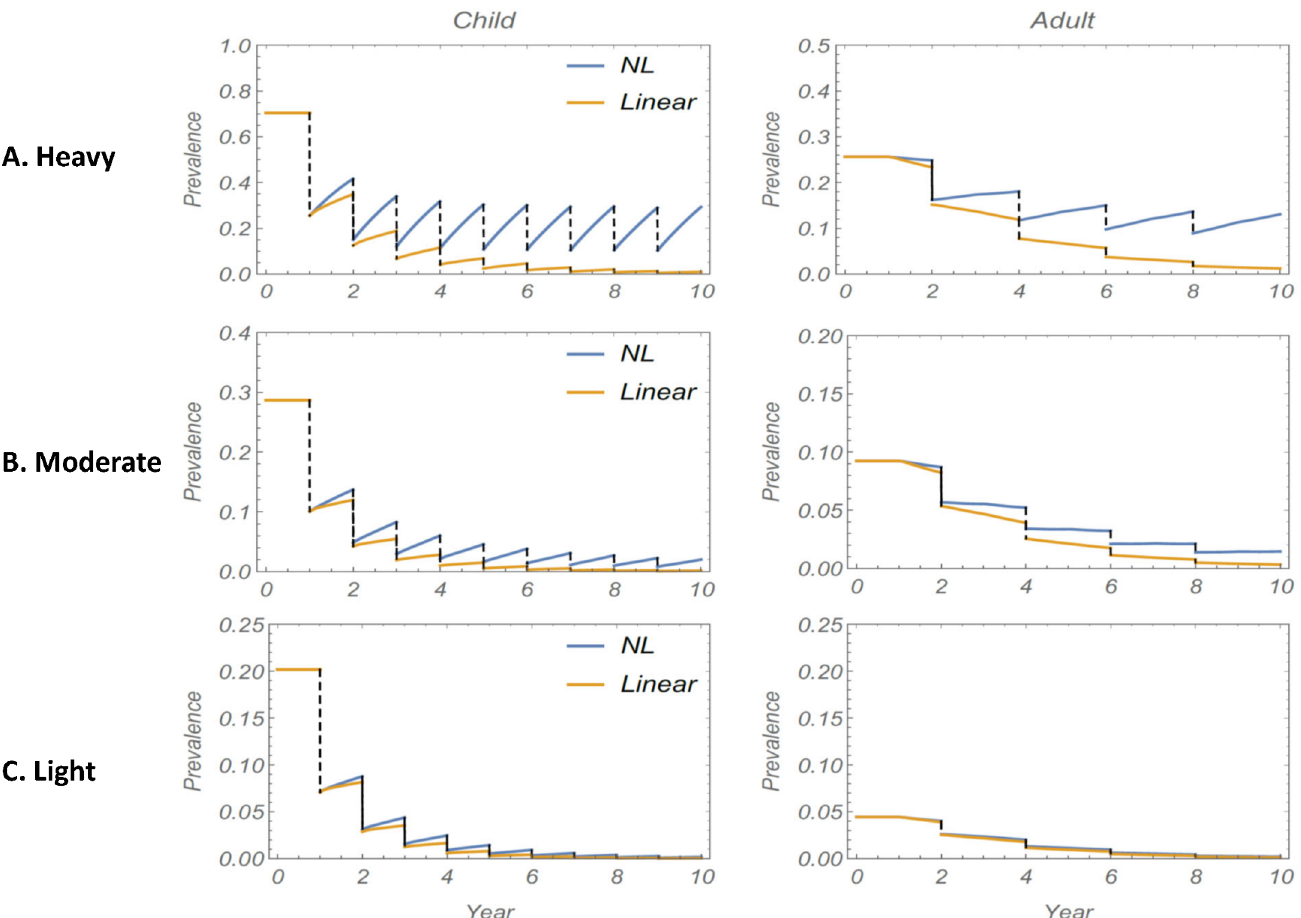
Fig 6. Comparison between M1 and M2 projections for a 10-year MDA regimen in three classes of transmission community. The three plots (A)-(C) show the difference between using a linear (M1) vs. a non-linear (M2) snail FOI input in simulations of MDA program prevalence outcomes in high transmission setting ((A), top panels), moderate transmission settings ((B), middle panels) or low transmission settings ((C), bottom panels) for children (left side graphs) and adults (right side graphs). M1 (linear, yellow lines) and M2 (NL, blue lines) projections diverge significantly in (A), but are very close in in low transmission settings (C), where both projections follow a similar decay